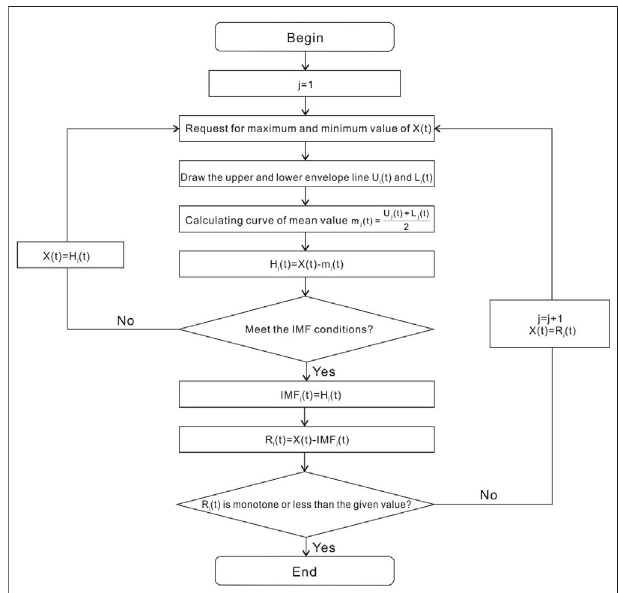
FIGURE 10 | Calculating fl ow of EMD